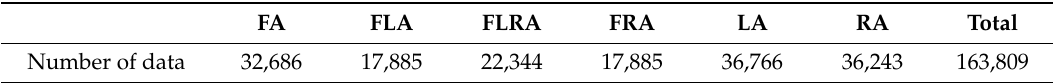
Table 3. Number of data for our experiments.